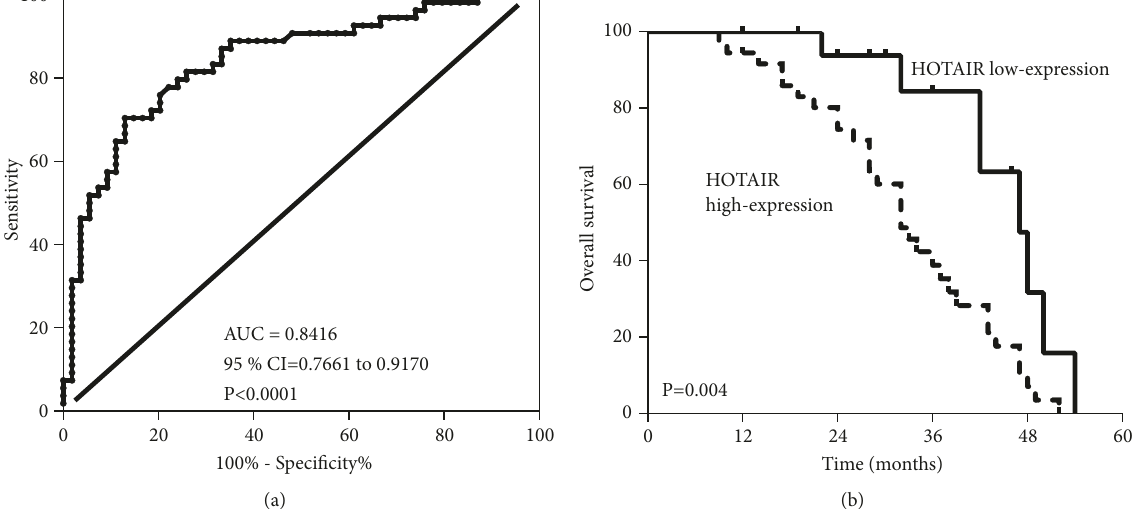
Figure 2: HOTAIR was a potential diagnostic and prognostic marker. (a) Receiver operation characteristics (ROC) curve for prediction of GC using HOTAIR expression level. (b) Survival of patients in HOTAIR low expression group and high expression